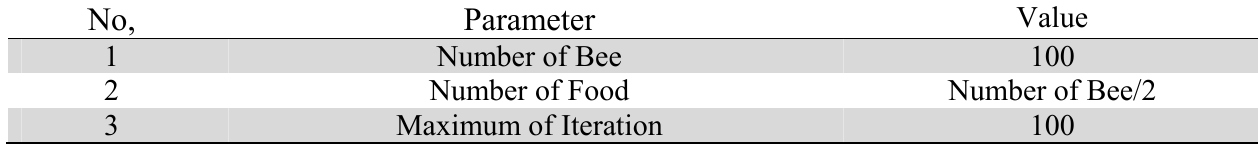
Adjusted parameters in MATLAB to run the Artificial Bee Colony Algorithm